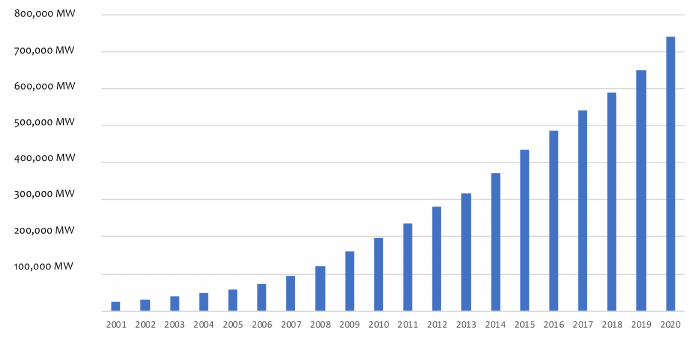
Figure 2. Annual growth of power renewable capacity source statista